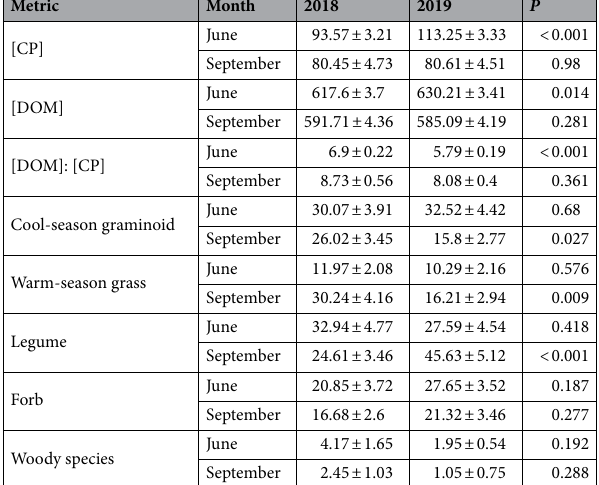
Table 1. Comparison between years of mean dietary quality and functional group abundance in